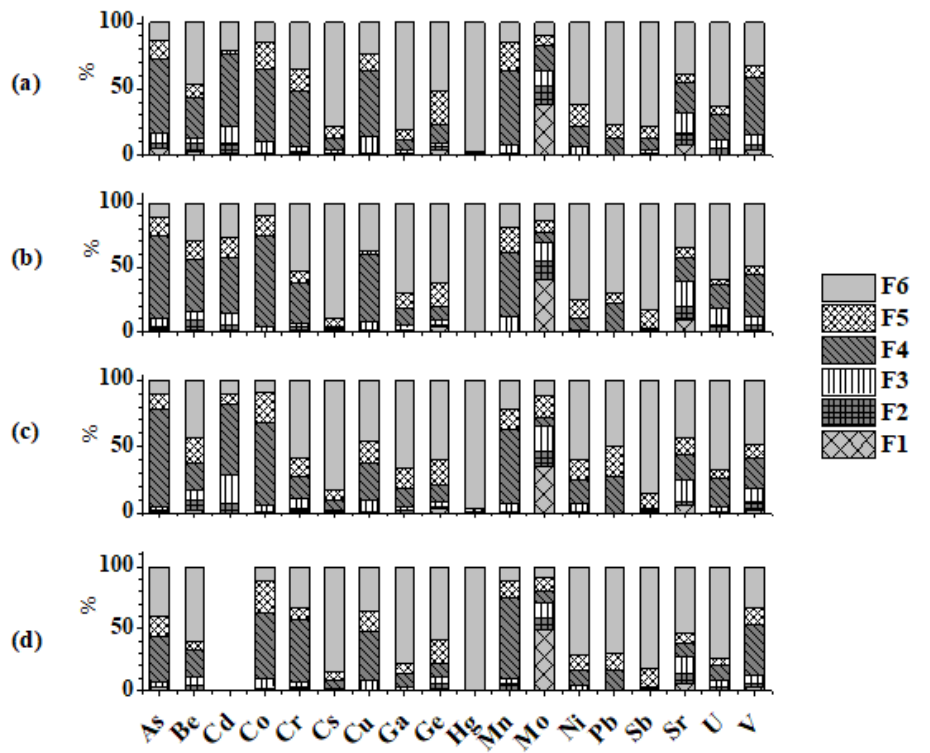
Figure 3. Distribution of investigated trace elements in fly ashes: TPPKb ( a ), TPPKs ( b ), TPPNT ( c ), and CFB ( d ) among the water-soluble fraction (F1), the exchangeable fraction (F2), the carbonate bound fraction (F3), the metal oxide bound fraction (F4), the organic bound fraction (F5), and the residual fraction (F6).